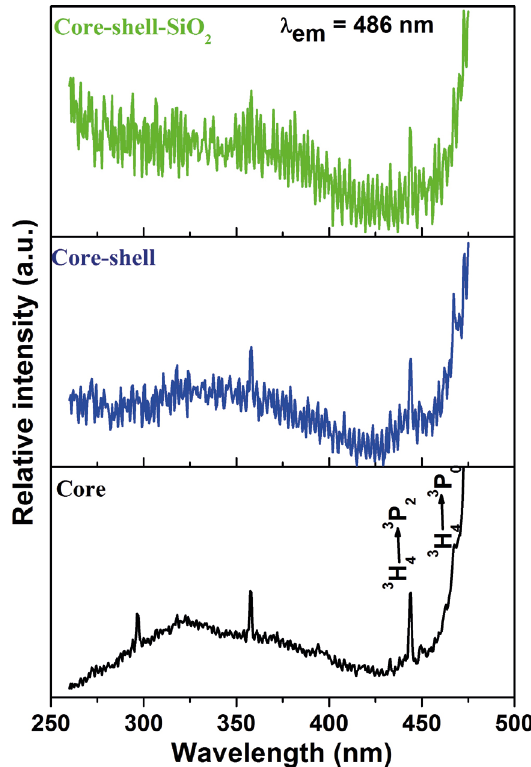
Figure 6. Excitation spectra of the core, core-shell and core-shell- SiO 2